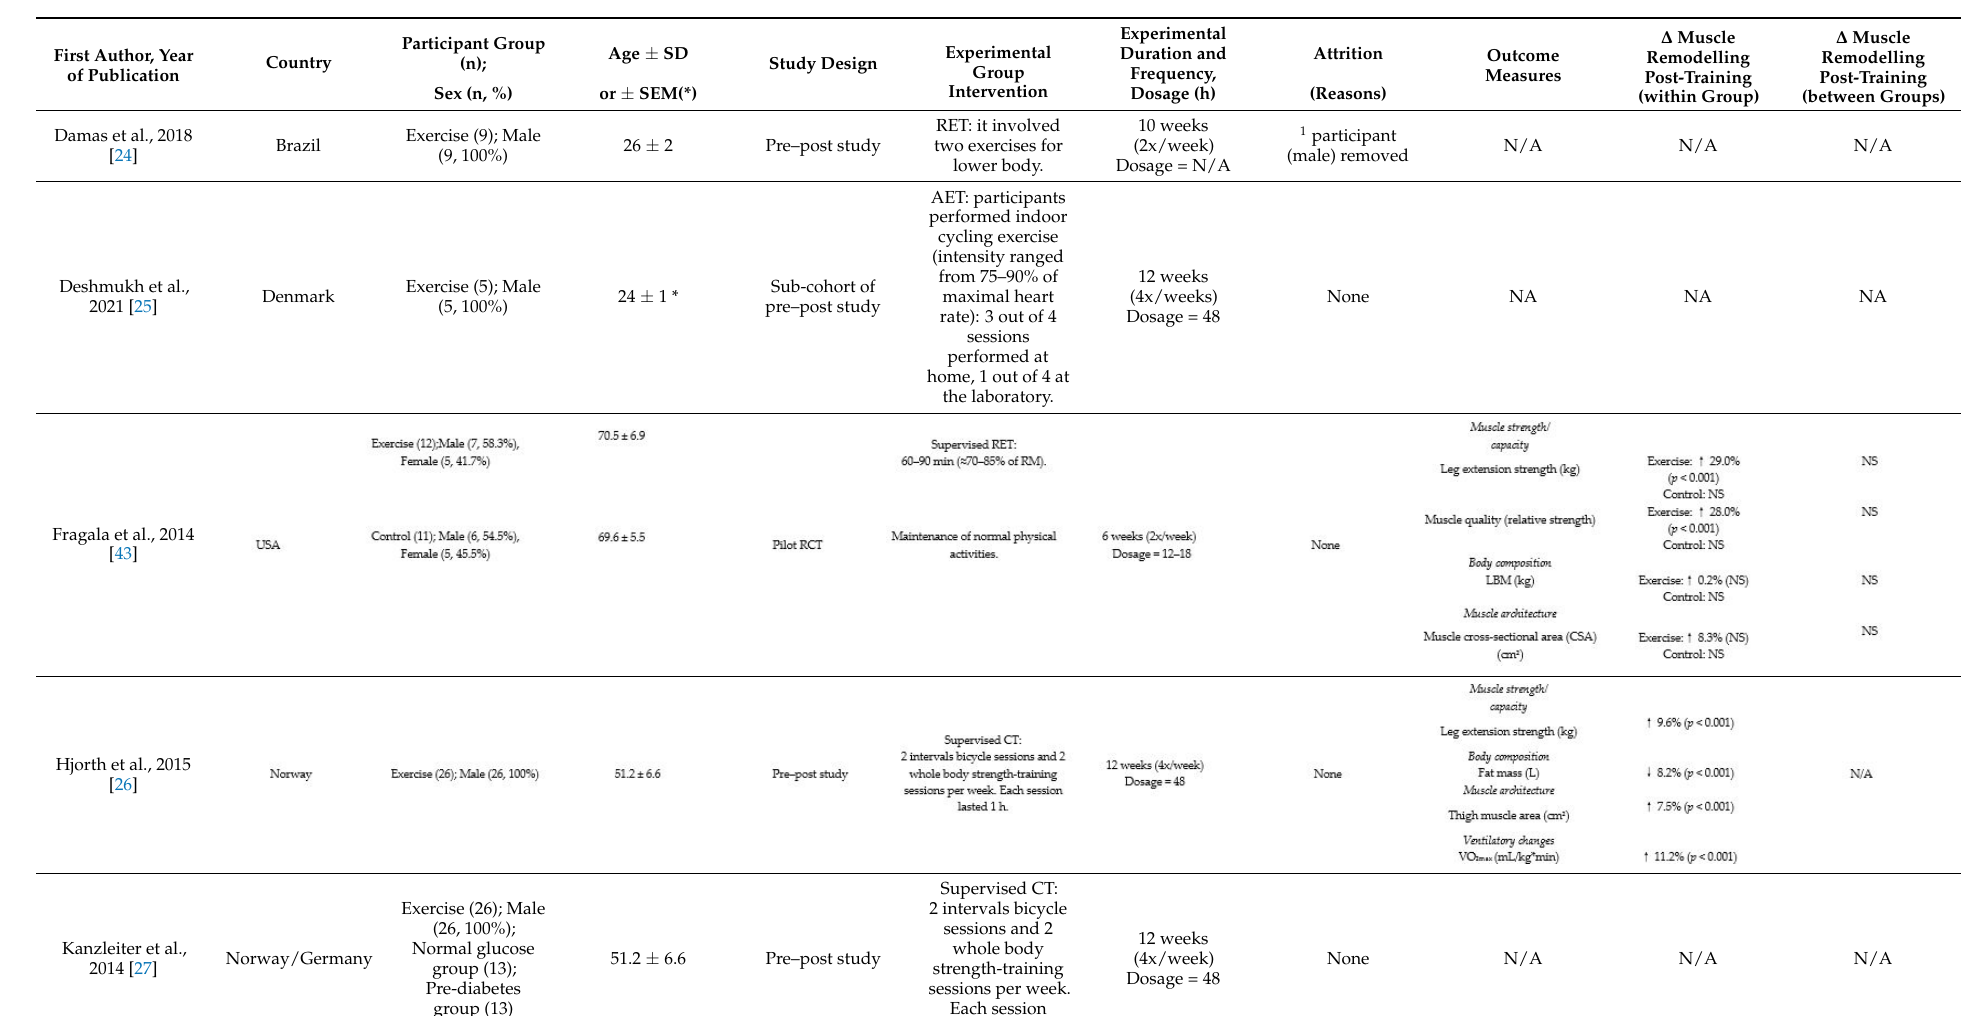
Table 3. Characteristics of the included studies, their participants and muscle remodelling